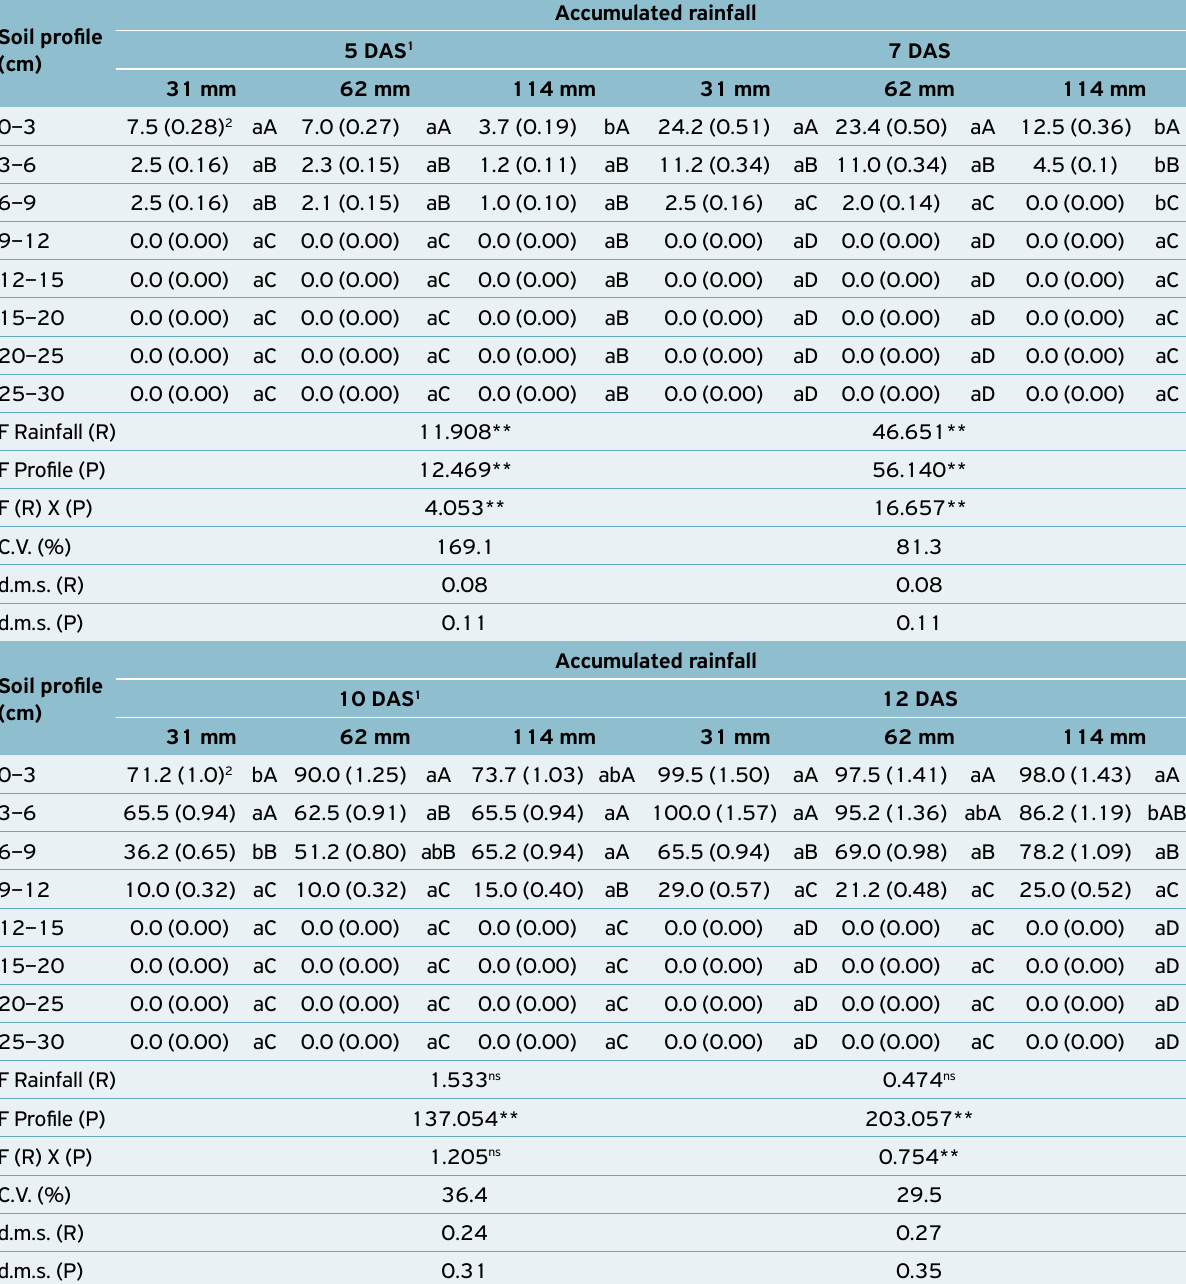
Table 3. Phytotoxicity percentage in cucumber plants after the application of tebuthiuron to a clayish-textured soil under different rainfall amounts. Botucatu, São Paulo,